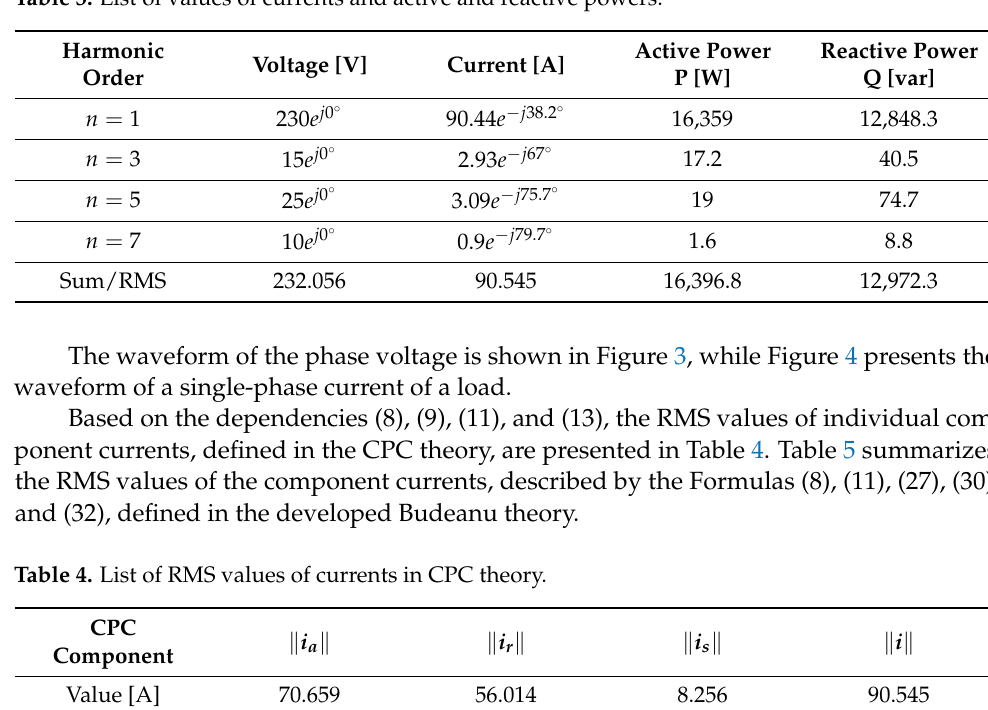
Table 3. List of values of currents and active and reactive powers.